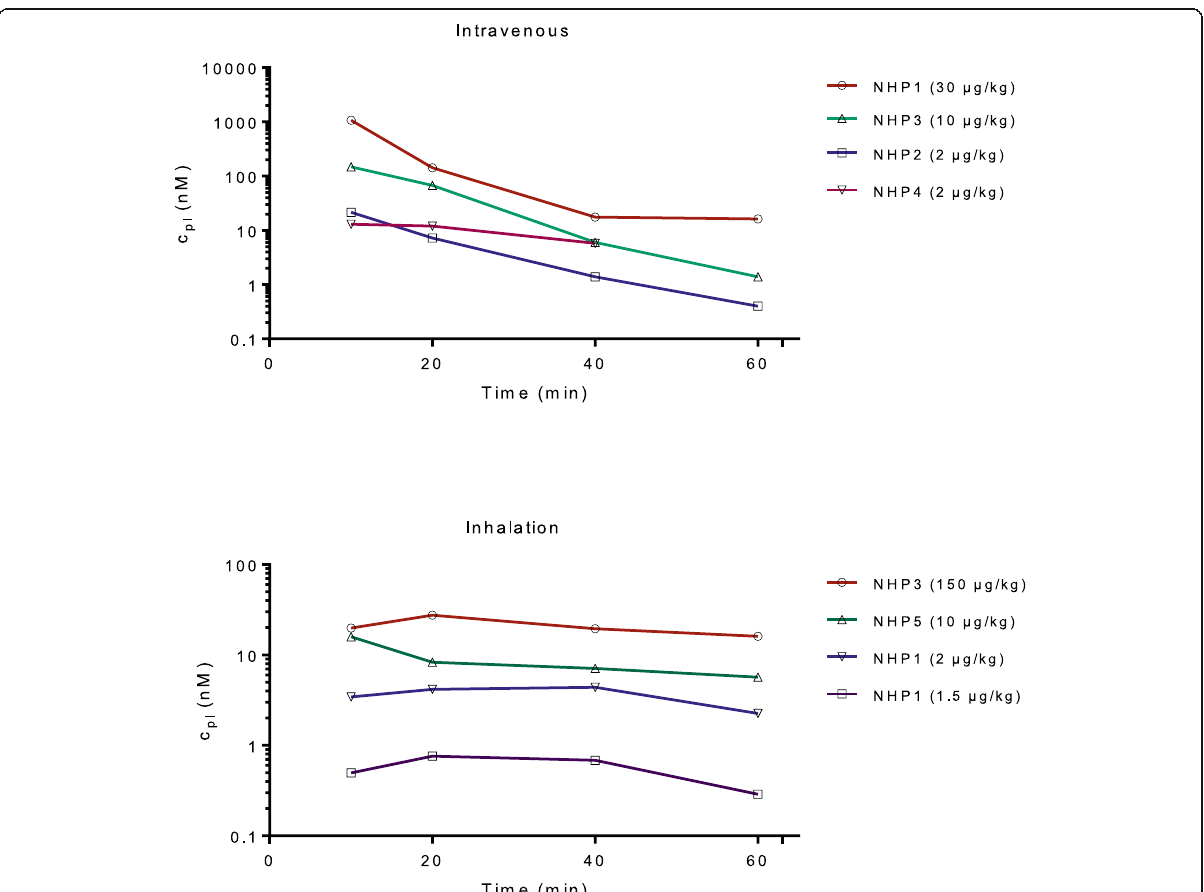
Fig. 1 Plasma ipratropium concentration during time of PET data acquisition following administration via intravenous infusion and inhalation. Note the different log scales on the Y